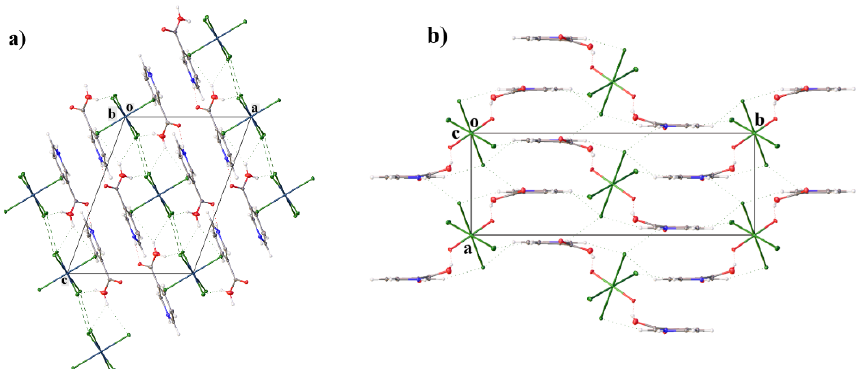
Figure 3. Crystal packing of I ( a ), showing the layers parallel to the plane ( − 101) with hydrogen and halogen bonds between them, and II ( b ), showing the layers parallel to plane (010) with hydrogen bonds between them.